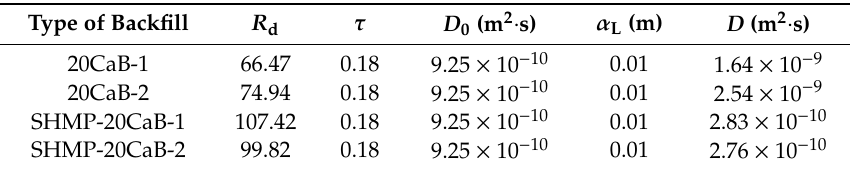
Table 3. Summary of transport parameters for Pb in